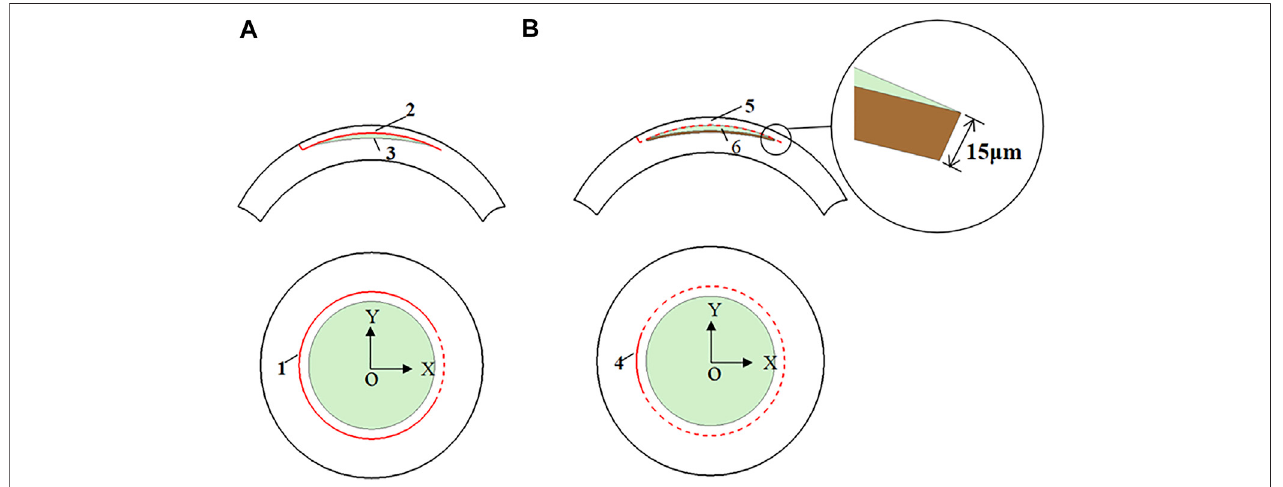
FIGURE 3| The model features ofthe LASIK and SMILE procedure. (A) LASIK procedure (1 fl ap opening incision; 2corneal fl ap; 3 lenticule); (B) SMILE procedure (4 cap opening incision; 5 corneal cap; 6 lenticule).